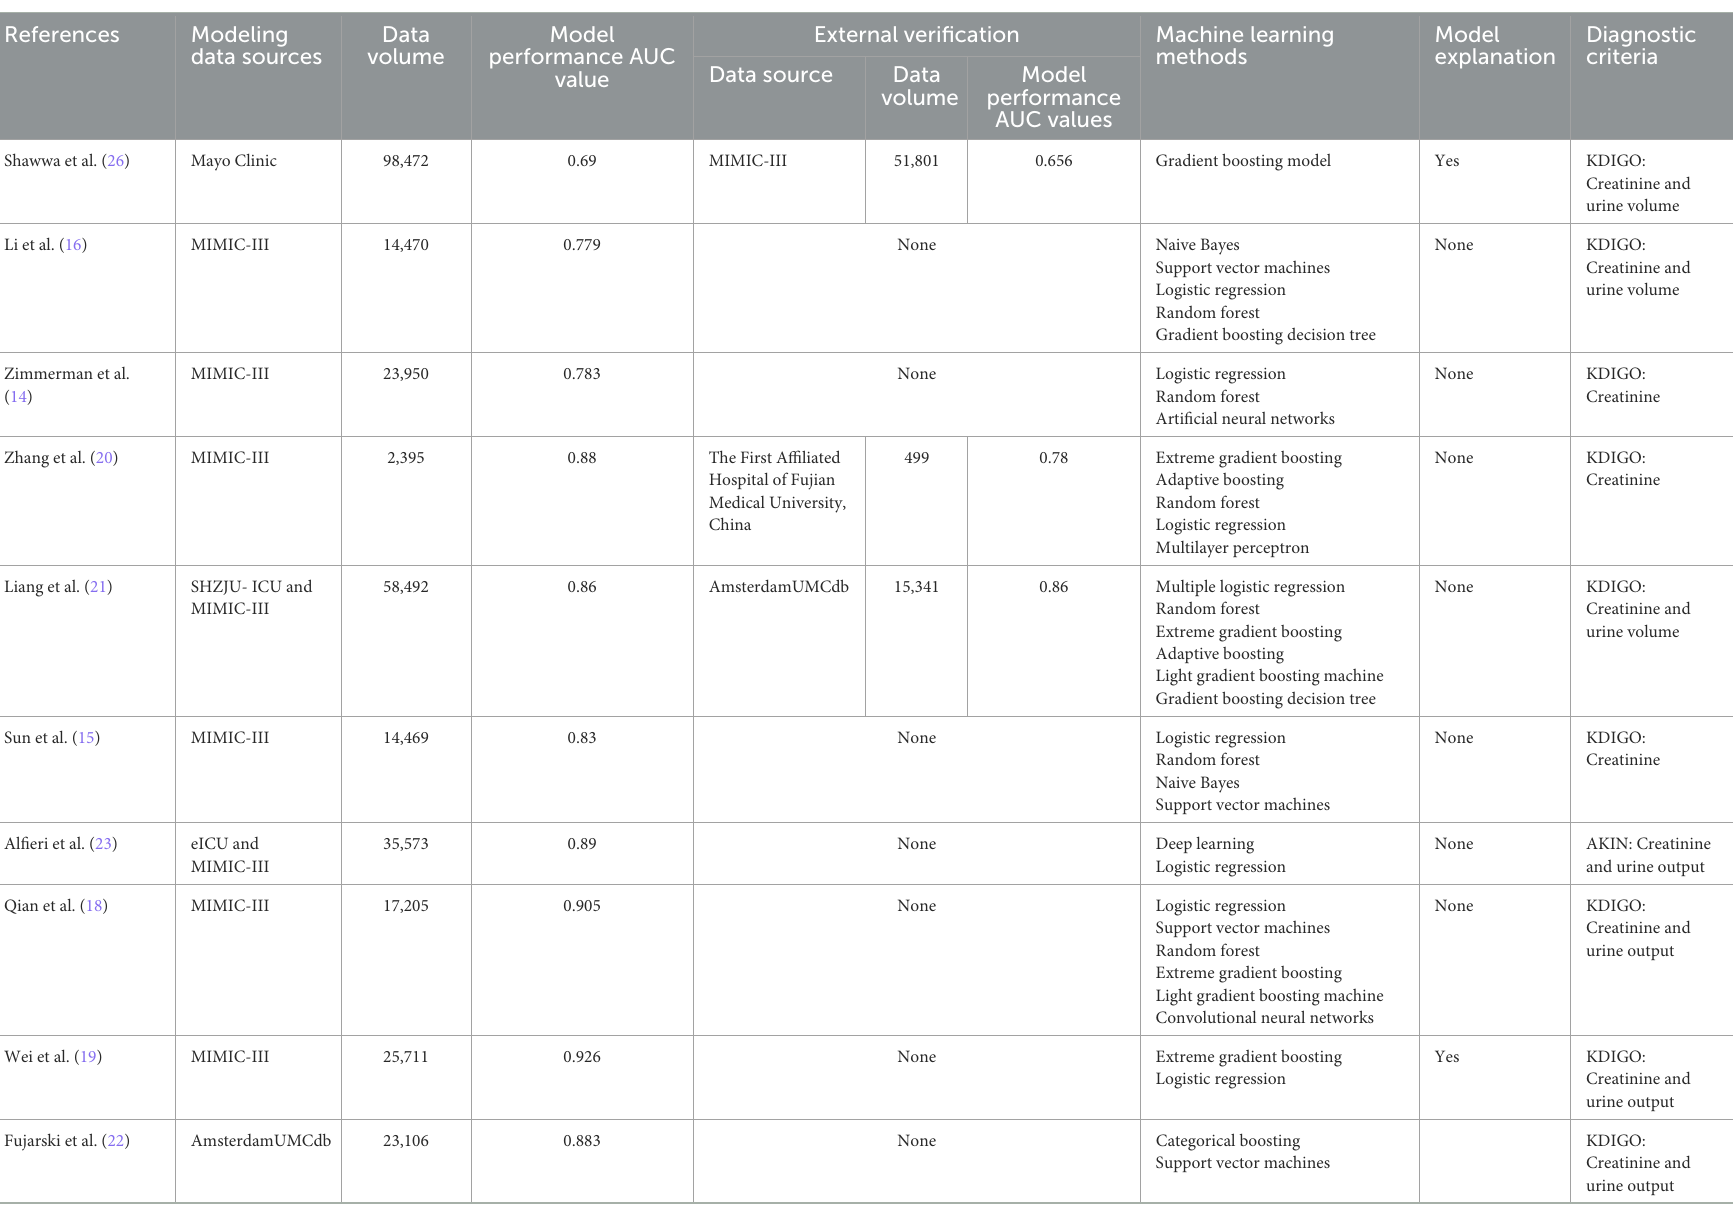
TABLE 2 AKI prediction model for critical care